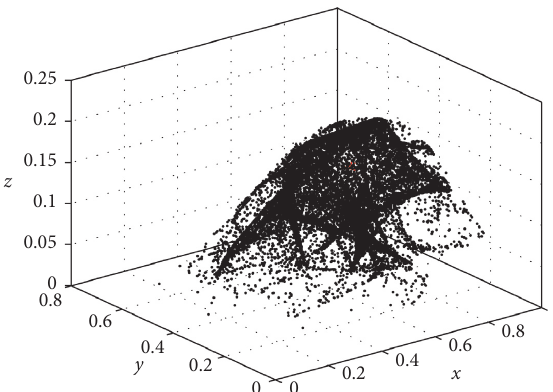
Figure 4: The chaotic attractor of the food chain model with an unstable fixed point ( b � 3.7, c � 3, d � 3.5, r � 3.8, and a �